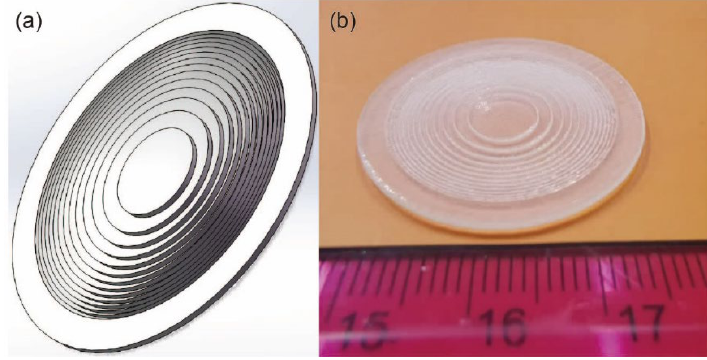
Figure 4. ( a ) Structure diagram and ( b ) Physical figure of Fresnel lens.